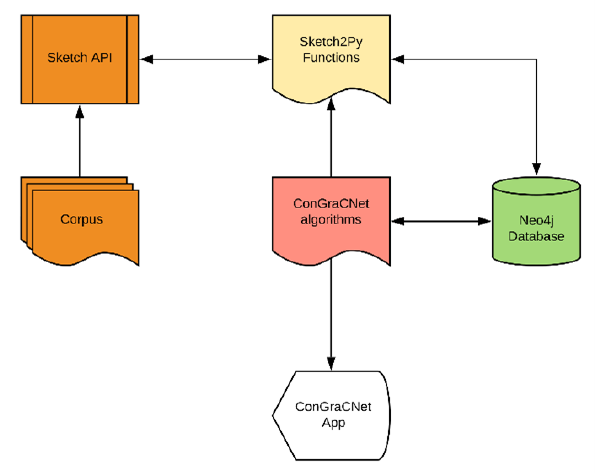
Figure 1. EmoCnet project ConGraCNet application methodology